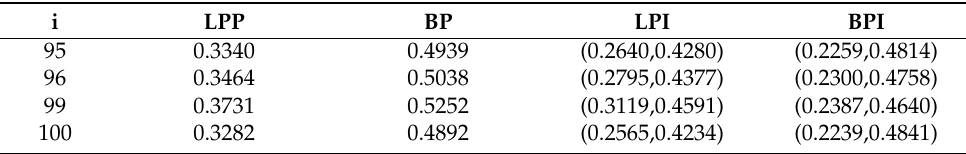
Table 12. Prediction results under high-voltage power transformers